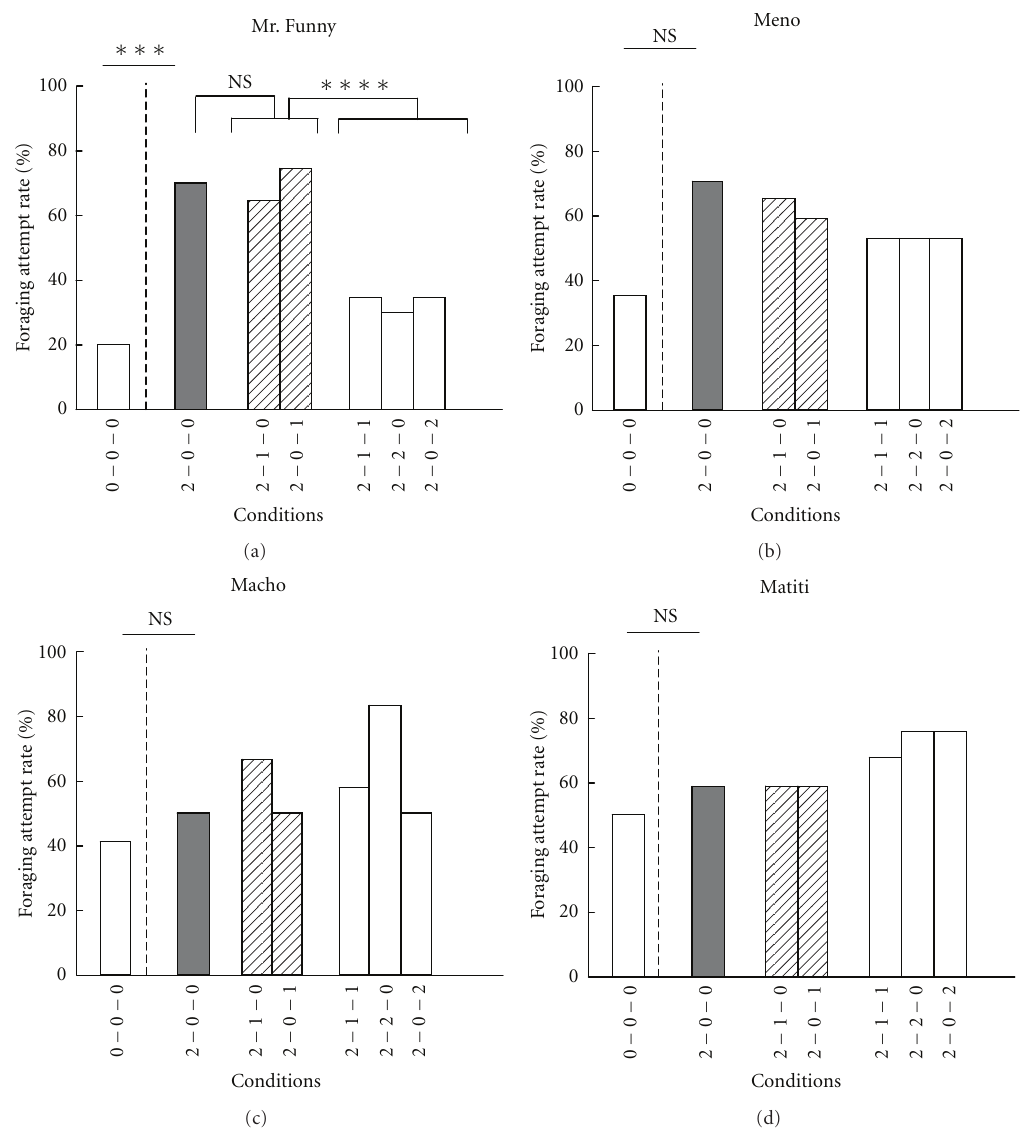
Figure 6: “Foraging attempt” rates for simultaneous visibility. The “foraging attempt rates” were expressed as the percentage of “attempt made” trials over the total number of trials in each condition for each subject. The number of sessions completed was 20 for Mr. Funny, 17 for Meno, and 12 for Macho and Matiti. ∗ ∗ ∗∗ : P < . 001, ∗ ∗ ∗ : P < . 01. P values are two